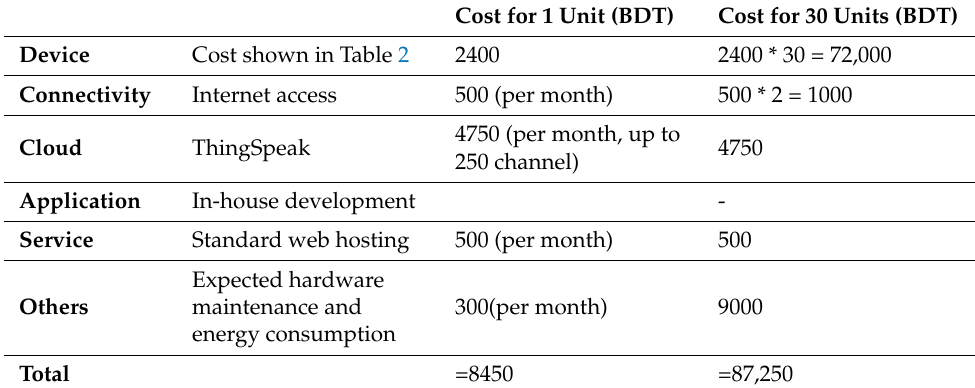
Table 3. Cost estimation of 30